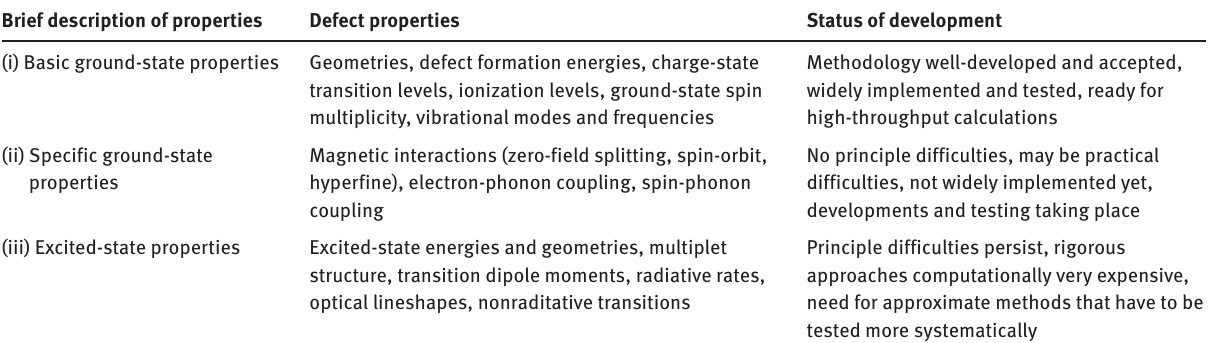
Table 3: Categories of point-defect properties organized according to the development of theoretical methodology for quantitative calculations. Brief description of